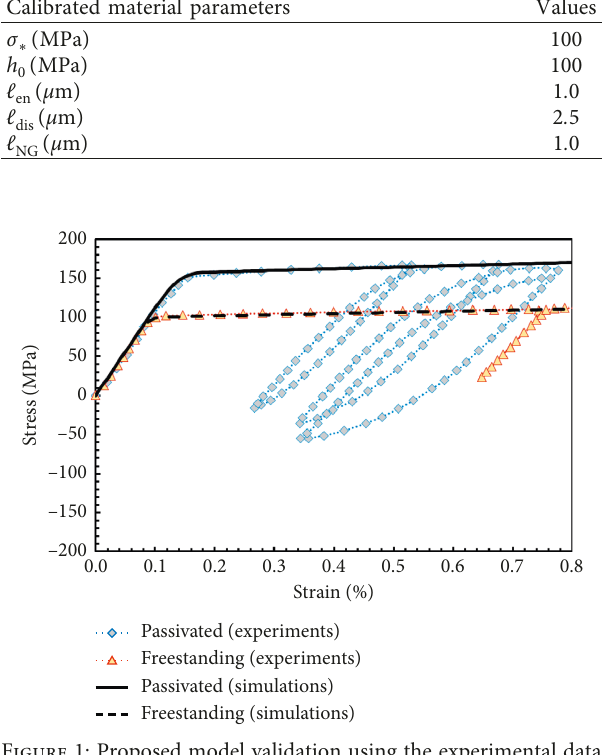
Figure 1: Proposed model validation using the experimental data in [24] on the stress-strain responses in aluminium thin